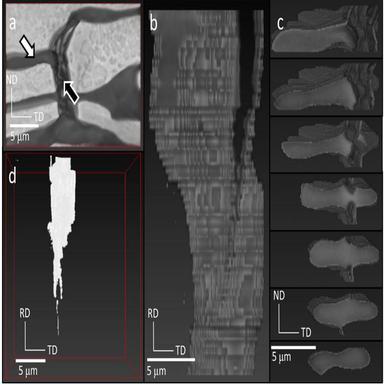
(a) SEM image of a crack at surface of sample. A ductile phase ligament of interest is highlighted by white arrow, the crack shown by black arrow. (b) A side view of the ductile phase ligament with the top being the surface of the bar, and bottom ~25 μm into the sample interior. (c) A series of slice views of same ductile phase ligament at the following depth increments from top to bottom: surface, 5, 10, 12.5, 15, 20, and 25 μm deep. (d) A side view of the crack shown by the black arrow in (a). For interp